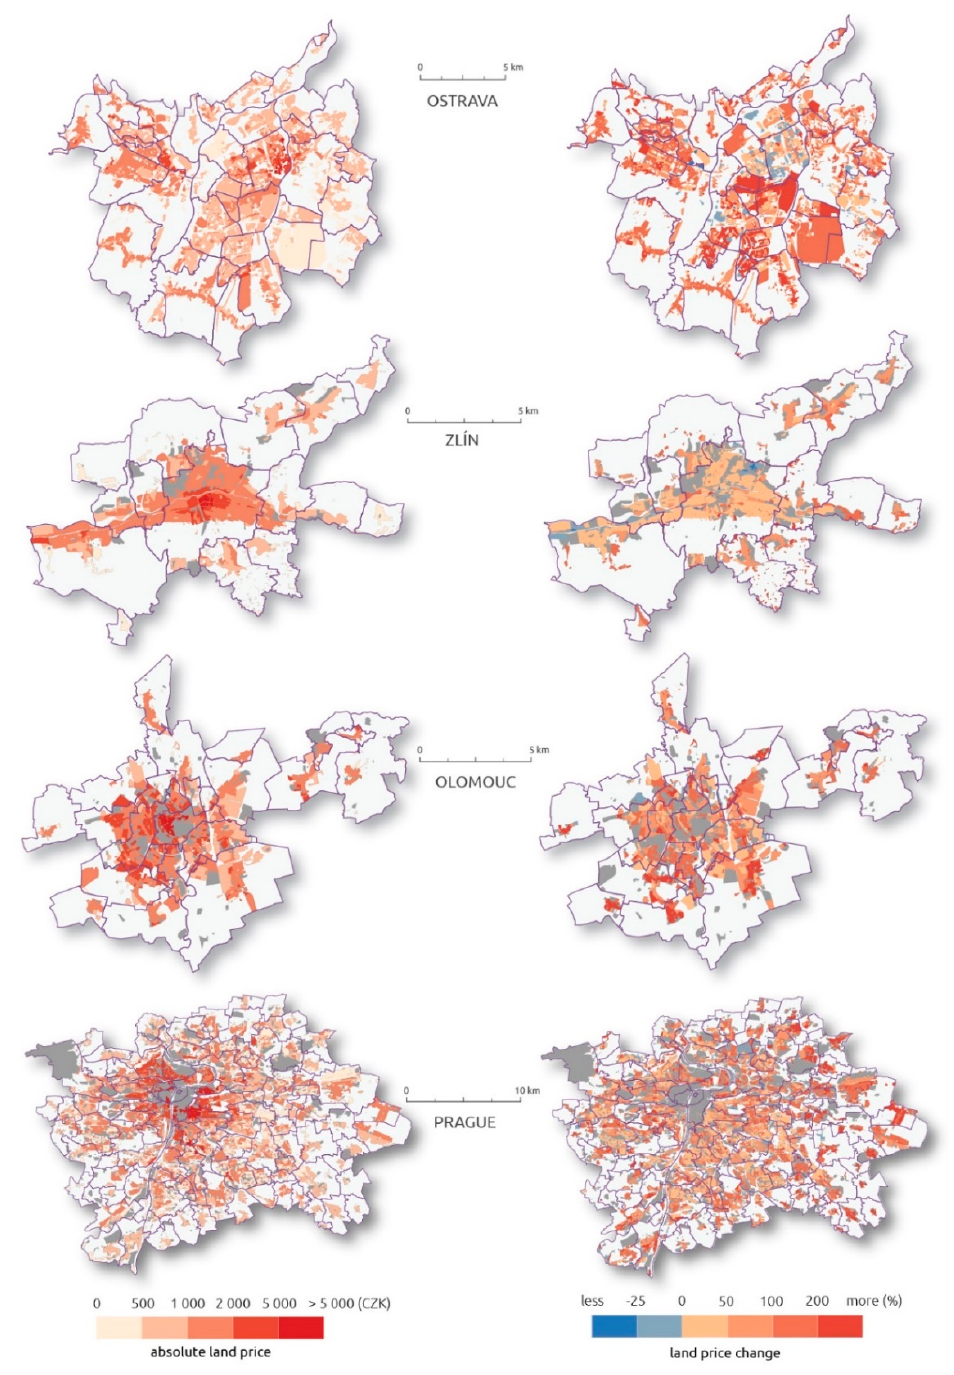
Figure7. Absolutelandpricesin2006andrelativelandpriceschangesbetween2006and2019(adi ff erent Figure 7. Absolute land prices in 2006 and relative land prices changes between 2006 and 2019 (a scale was used for absolute values in Prague, as follows: 0–3000–6000–9000–15,000 and